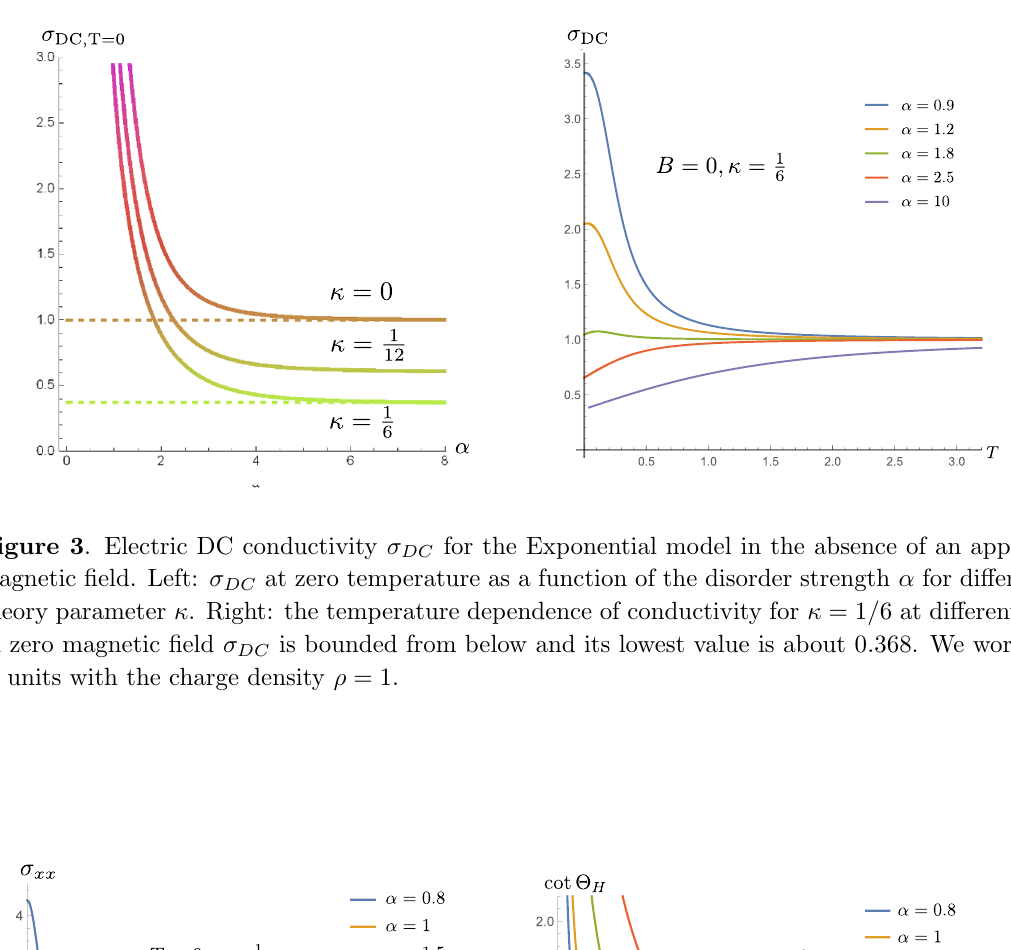
= (cid:27) =(cid:27) which can be used to measure xx xy H indeed decreases monotonically as B is increased. H